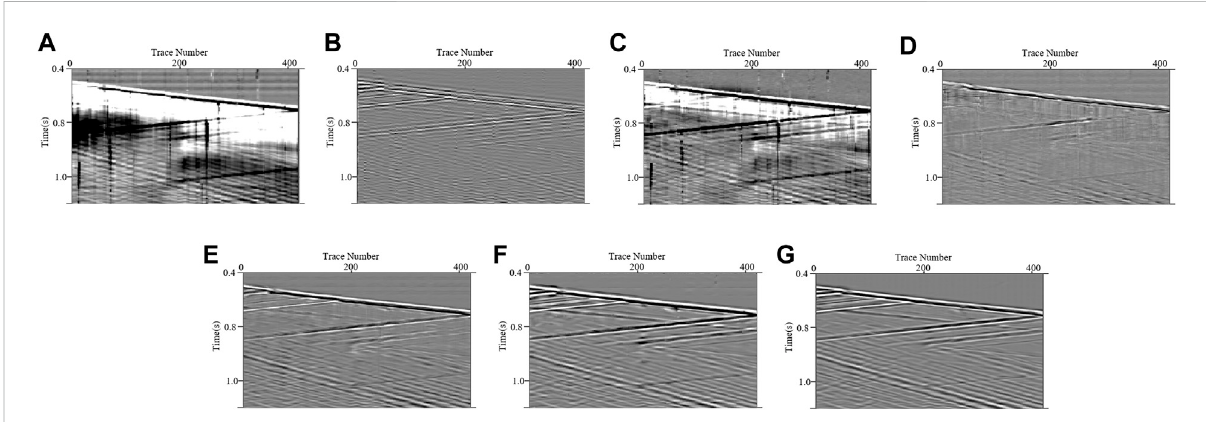
FIGURE 8 The enlargements for the results shown in Figure 7: (A – G) represent the enlarged denoising results obtained by TFPF, BPF, RPCA, DnCNN, U-Net, RED-Net and